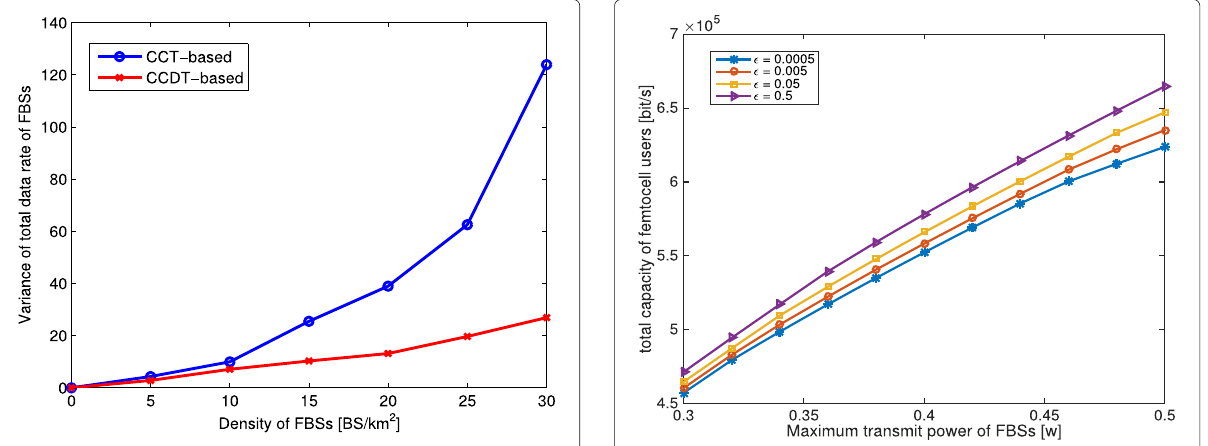
Fig. 4 Variance of average data rate of FUEs of FBSs for different density of FBSs